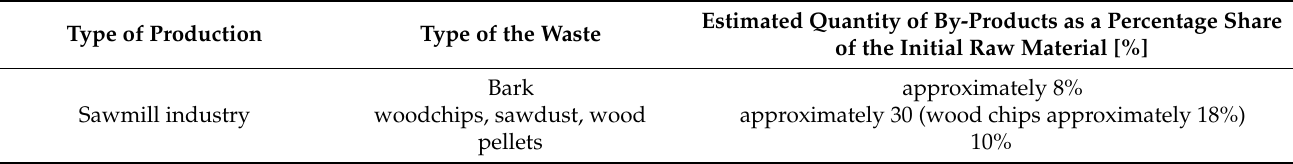
Table 4. Types and estimated quantity of generated wood by-products.